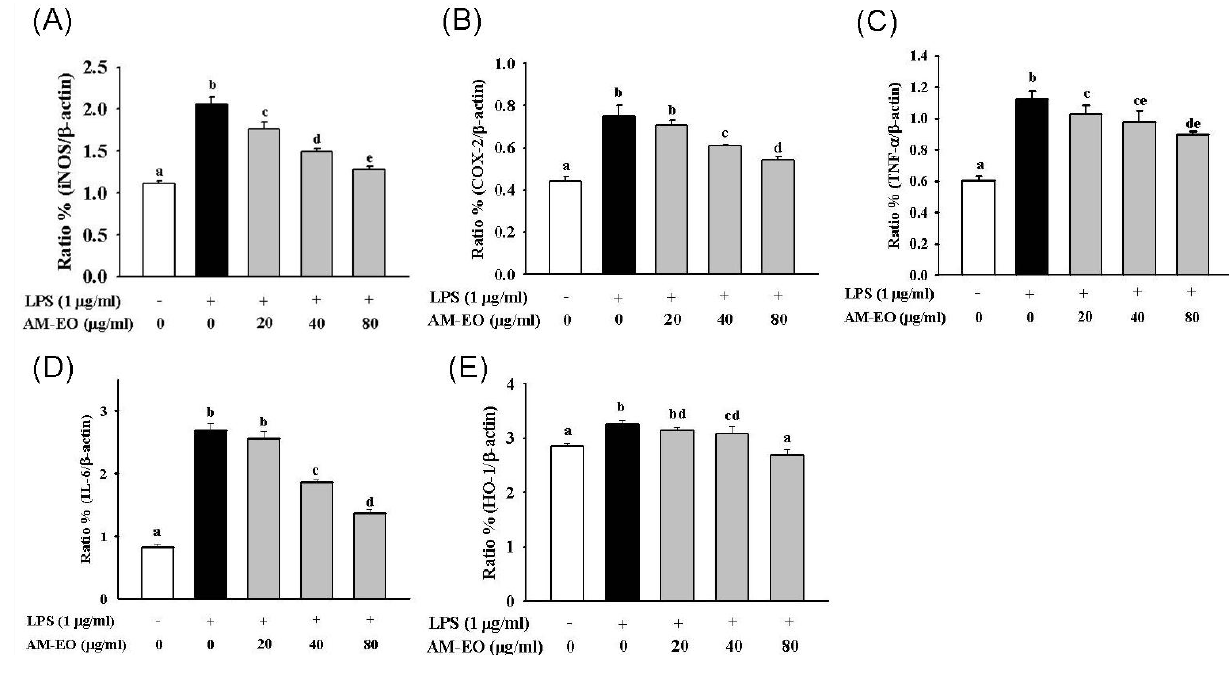
Figure 6. The quantitative mRNA ratio of ( A ) iNOS, ( B ) COX-2, ( C ) TNF- α , ( D ) IL-6 and ( E ) HO-1. Each value represents the mean ± SD ( n = 3). Groups sharing the same superscript letter are not significantly different ( p > 0.05) as revealed by Dunnett’s post hoc